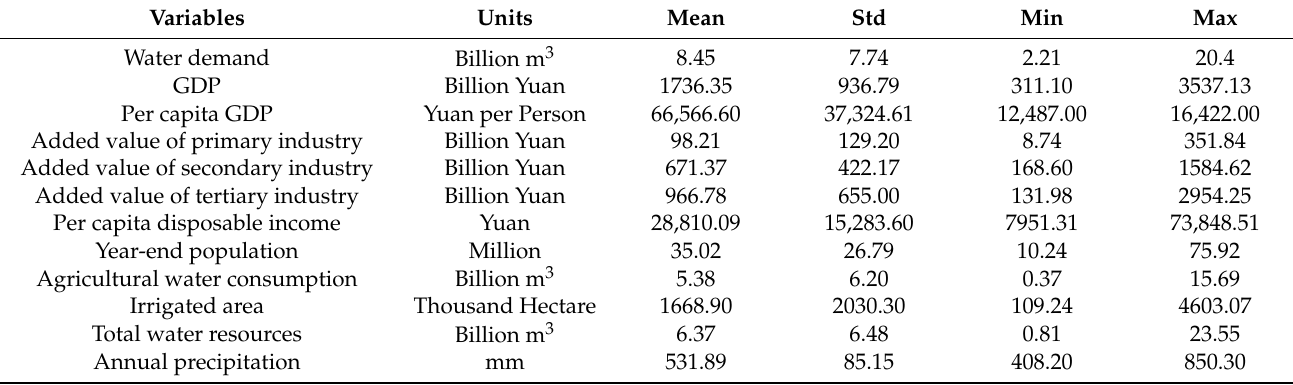
Table A1. Basic statistics of the variables used in the study. (The abbreviations of the standard deviation is